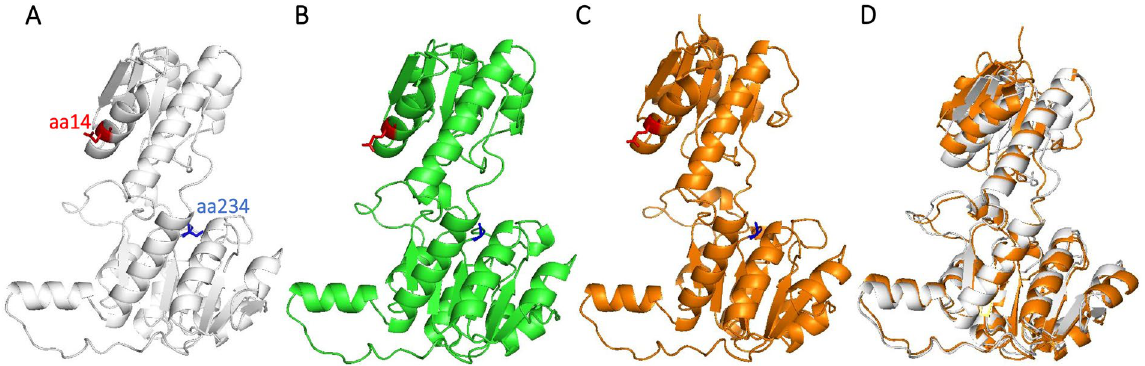
Figure 4. 3D-structures of Ddhs represented by cartoon diagrams. ( A ) Structure of Sy Ddh generated by SWISS-MODEL. ( B ) 3D-structure of Ddh from Pseudomonas aeruginosa PAO1 (PDB ID: 3WWZ). ( C ) 3D-structure of Ddh from Fusobacterium nucleatum subsp. nucleatum ATCC 25586 (PDB ID: 3WWY). Amino acid residues at positions 14 and 234 of Sy Ddh and equivalent amino acid residues in Ddhs from Pseudomonas aeruginosa and Fusobacterium nucleatum were marked red and blue respectively. ( D ) Superposition of Sy Ddh and Ddh from Fusobacterium nucleatum subsp. nucleatum ATCC